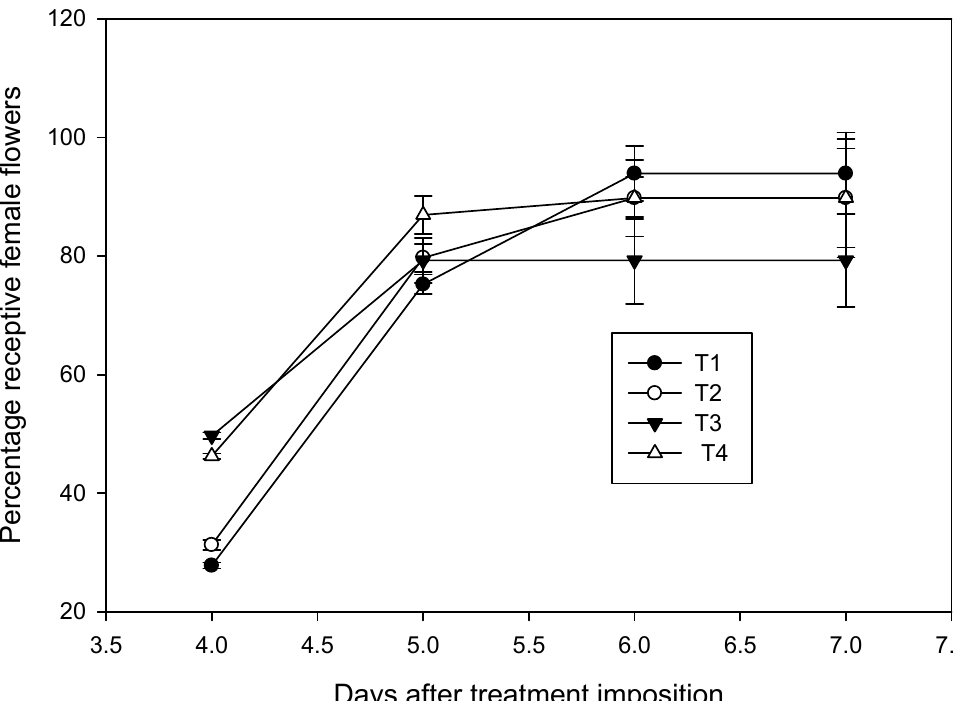
Figure 8. Effect of high temperature treatment on female flower receptivity of the field ‐ grown coconut variety WCT. Receptivity of female flowers, which was denoted by splitting of white stigma and secretion of nectar, of ambient grown plants (T1) was compared with percentage decline in receptivity of flowers in chamber control (T2), chamber with 3 ° C rise in temperature at 50 ± 5% RH (T3) and chamber with 3 ° C rise in temperature at 65 ± 5% RH (T4). Bars on the lines indicate mean ± SD. Temperature treatment to the inflorescencewas imposed six days before the female flower receptivity.